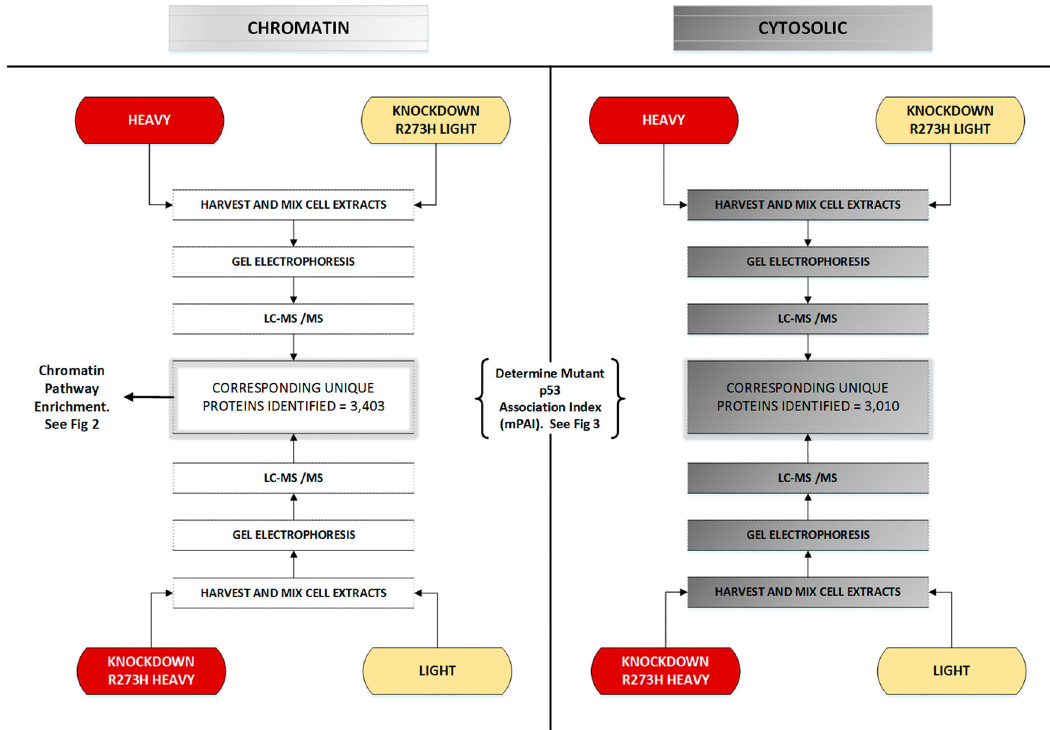
Fig. 1 SILAC work fl ow for proteomic targets. Four independent LC-MS/MS experiments were carried out to compare the proteomes of chromatin and cytosolic proteomes with mtp53 knockdown. The work fl ow diagram brie fl y details the scienti fi c steps from cell culture conditions to the identi fi cation of unique proteins. See Figs. 2 and 3 for identi fi cation of chromatin pathway enrichment and the mutant p53 association index for speci fi c proteins and pathways compared for chromatin and cytosolic